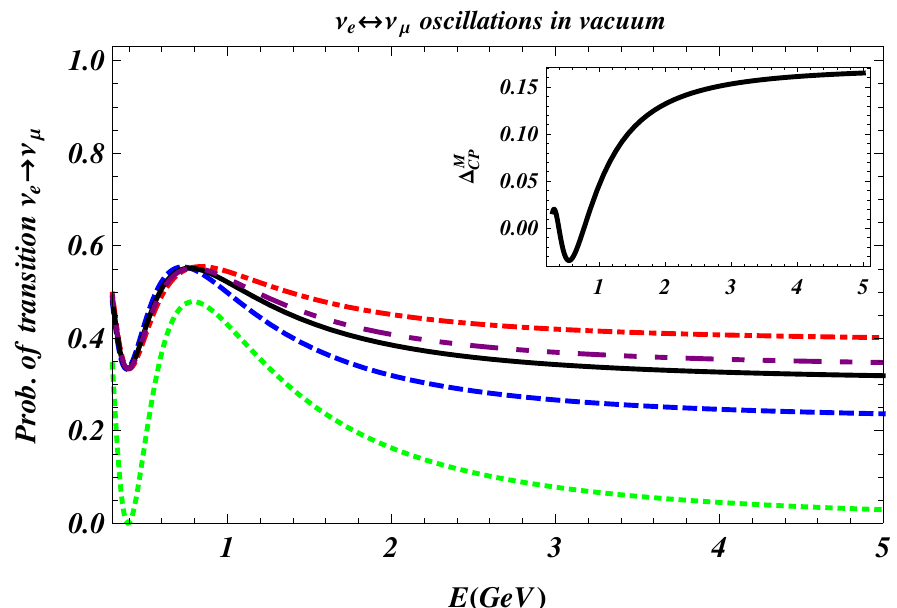
Figure 4. (Color online) Plots of P ν (red dot dashed line) and P ν (blue dashed line) for Majorana e → ν µ e → ν µ neutrinos and for Dirac neutrinos ( φ = 0, black line), as a function of E , in vacuum. The purple, dashed = P line is obtained by setting α = 0. In this case P ν ν e → ν µ . The Pontecorvo formula is represented e → ν µ by the green dotted line. We use the same values of φ and z of Figure 1, and consider: sin 2 θ 12 = 0.861, ∆ m 2 = 7.56 × 10 − 5 eV 2 , γ = 1.2 × 10 − 23 GeV, γ = 2.3 × 10 − 23 GeV, α = 1.1 × 10 − 23 GeV. Picture in 3 12 ( z ) the inset: plot of ∆ M CP